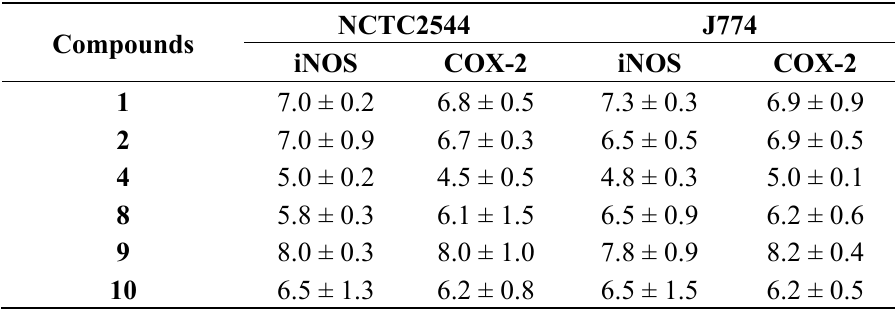
Table 1. iNOS and COX-2 IC values ( μ M) of human keratinocytes NCTC 2544 50 and mouse monocyte-macrophages J774 treated with interferon- γ plus histamine and lipopolysaccharides,